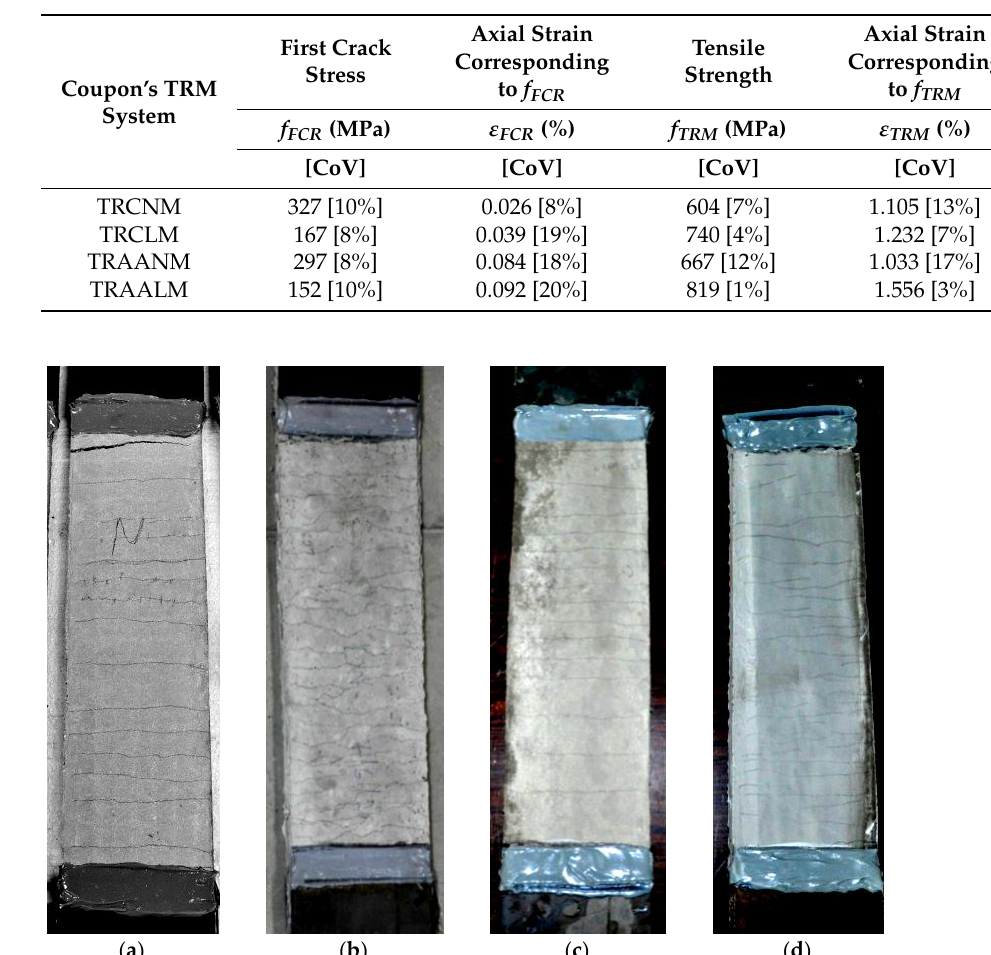
Figure 2. The coupons after tensile testing: ( a ) TRCNM, ( b ) TRCLM, ( c ) TRAANM, and ( d ) TRAALM.